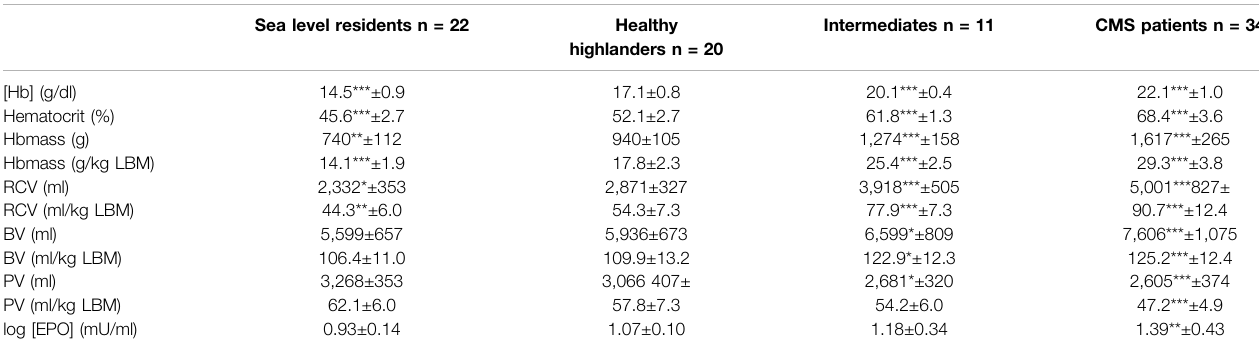
TABLE 3 | Hematological data, blood volumes, and serum EPO